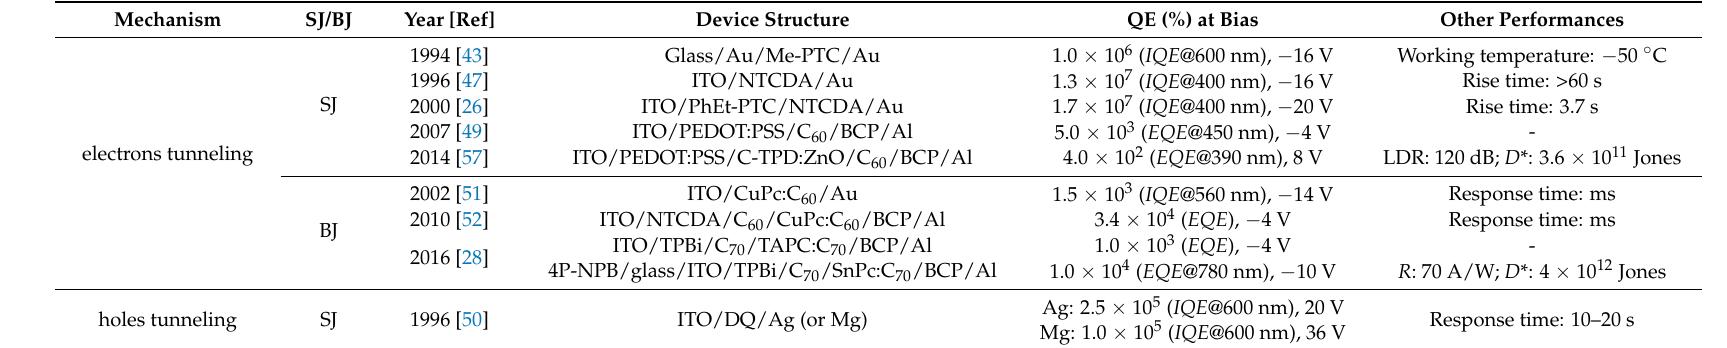
Table 1. Representative organic small molecular PM photodetectors and their performances.